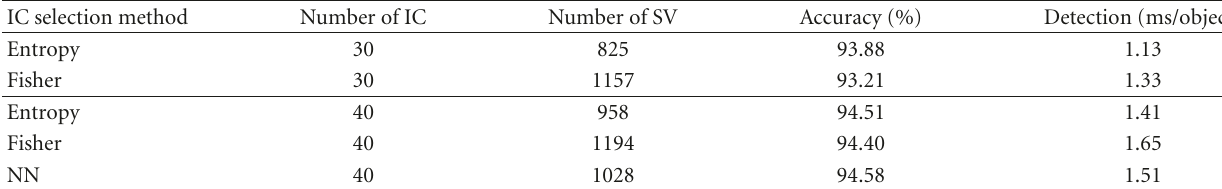
Table 2: Comparisons in the computational time.